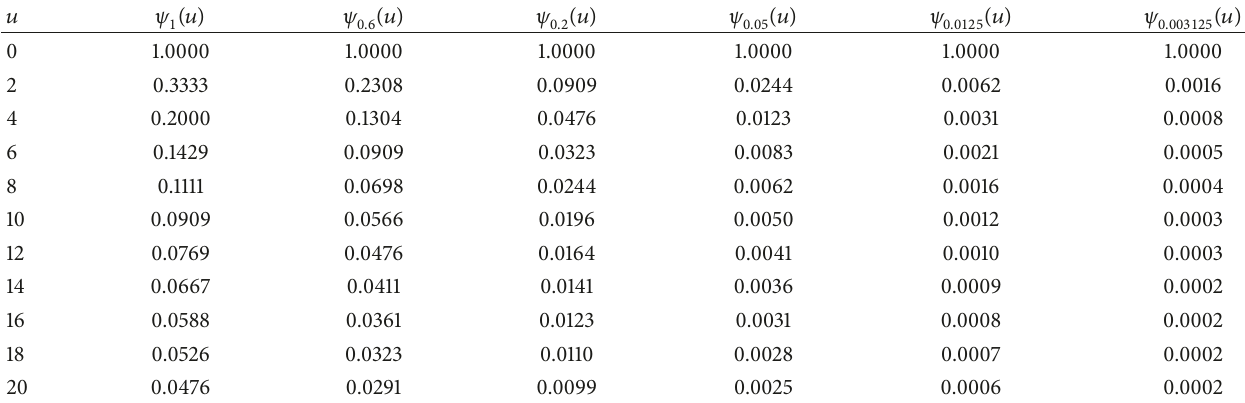
Table 5: Asympt. ruin prob. for CLM with proportional reins. (Pareto claims) ( 𝑐 = 6, 𝜆 = 2, 𝜃 = 𝜂 = 1